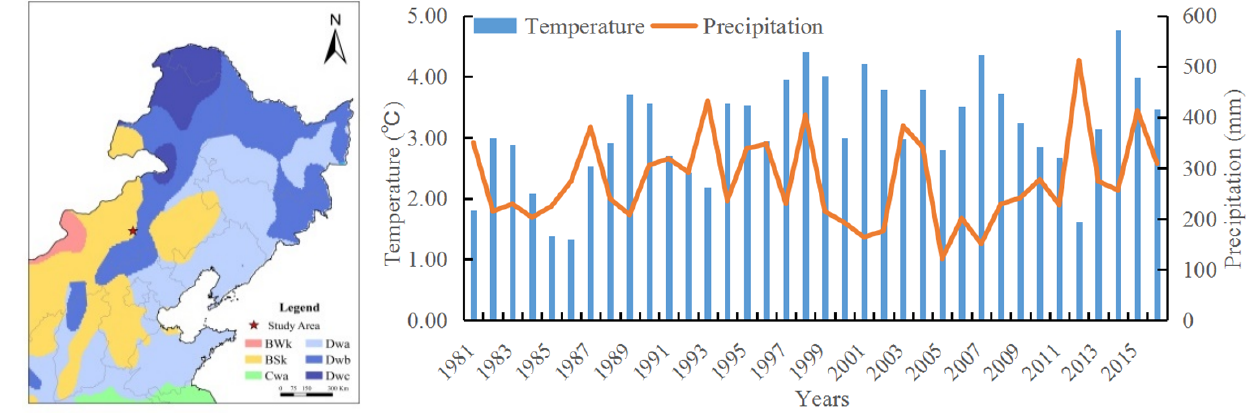
Figure 1. The mean temperature and mean precipitation from 1981 to 2016 in Xilin River Basin.